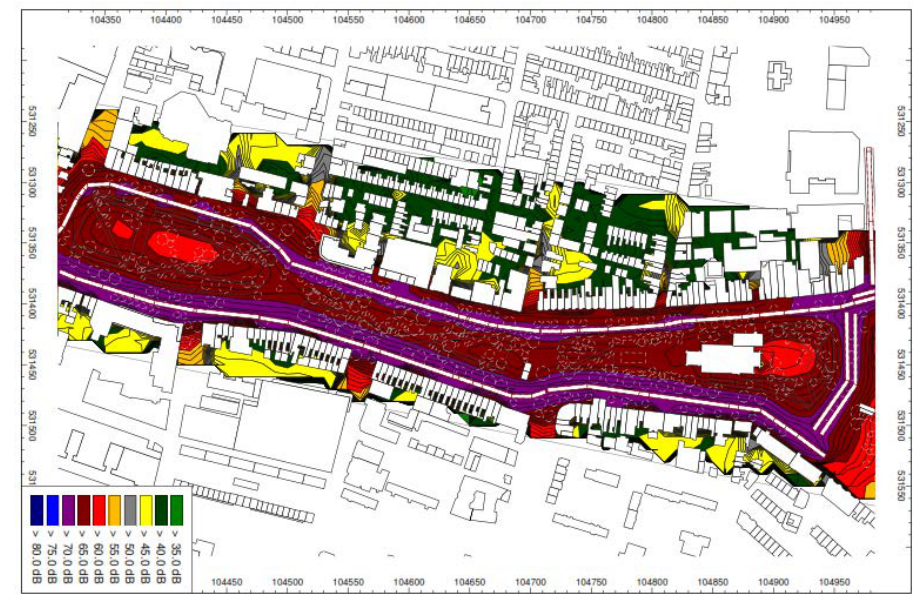
Figure 2: Noise map of the current scenario, before any intervention is made (L day )